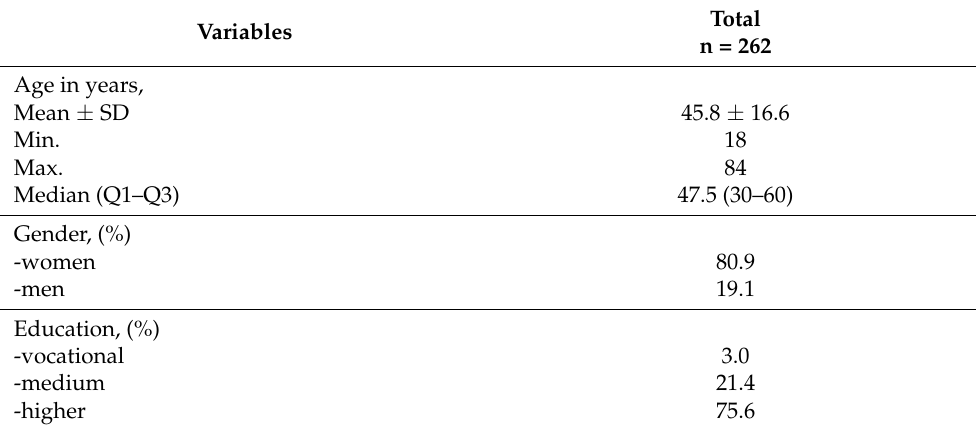
Table 1. Characteristics of the subjects (n =